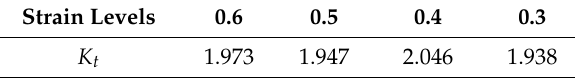
Table 3. Theoretical stress concentration factor of notch.